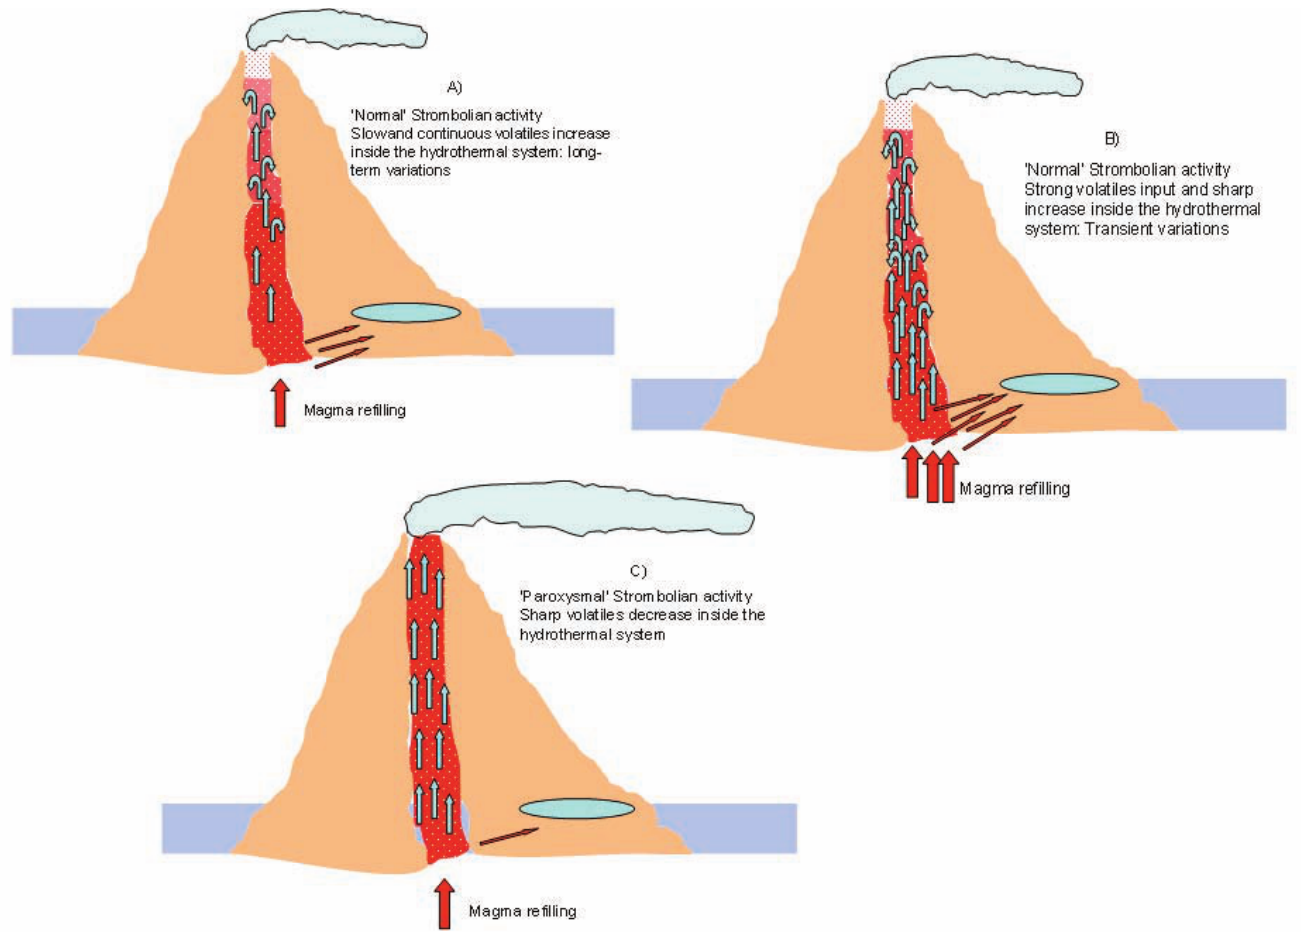
Figure 12. Schematical model of interactions between magmatic and shallow fluids in Stromboli volcano under the different conditions of the magma/pressure dynamics inside the "plumbing system" of the volcano. A) Input of exsolved gases from a magma body causes a progressive increase in the partial pressure of the dissolved gases in the peripheral thermal aquifers. B) Input of strong volatiles exsolved from the magma produce a sharp inside the hydrothermal system. C) Strongly increased degassing from the shallowest portion of the plumbing system (due to increase in the P CO2 paroxysmal events) causes a decrease in the partial pressure of the dissolved gases in the peripheral thermal